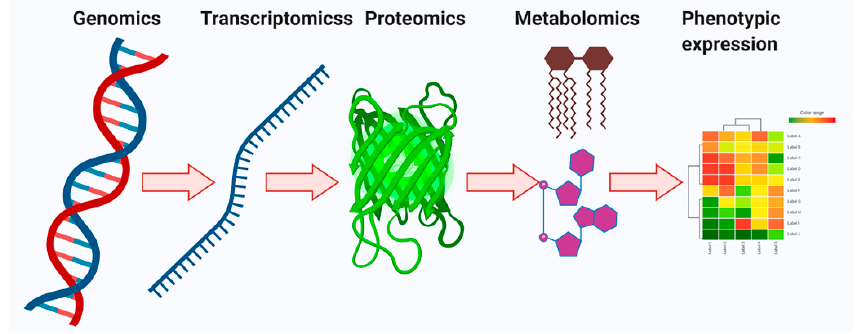
Figure 1. Overview of the central dogma, including fundamentals and design principles for multi- omics profiling in systems biology. The genomics, transcriptomics, proteomics, and metabolomics provide learning about DNA, mRNA, proteins, and metabolites, respectively. The multi-omics profiling in systems biology is influenced via epigenetics, age, diet, lifestyle, drugs, toxins, etc. Bilateral flow of cellular signals is detected between the genome, transcriptome, proteome, and